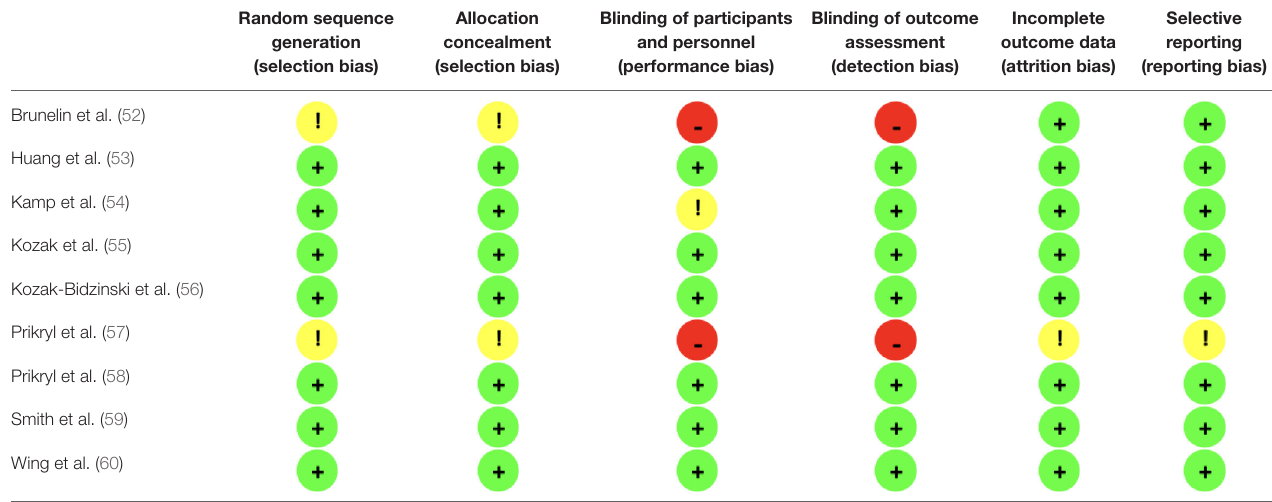
TABLE 1 | Outcomes of cochrane risk of bias